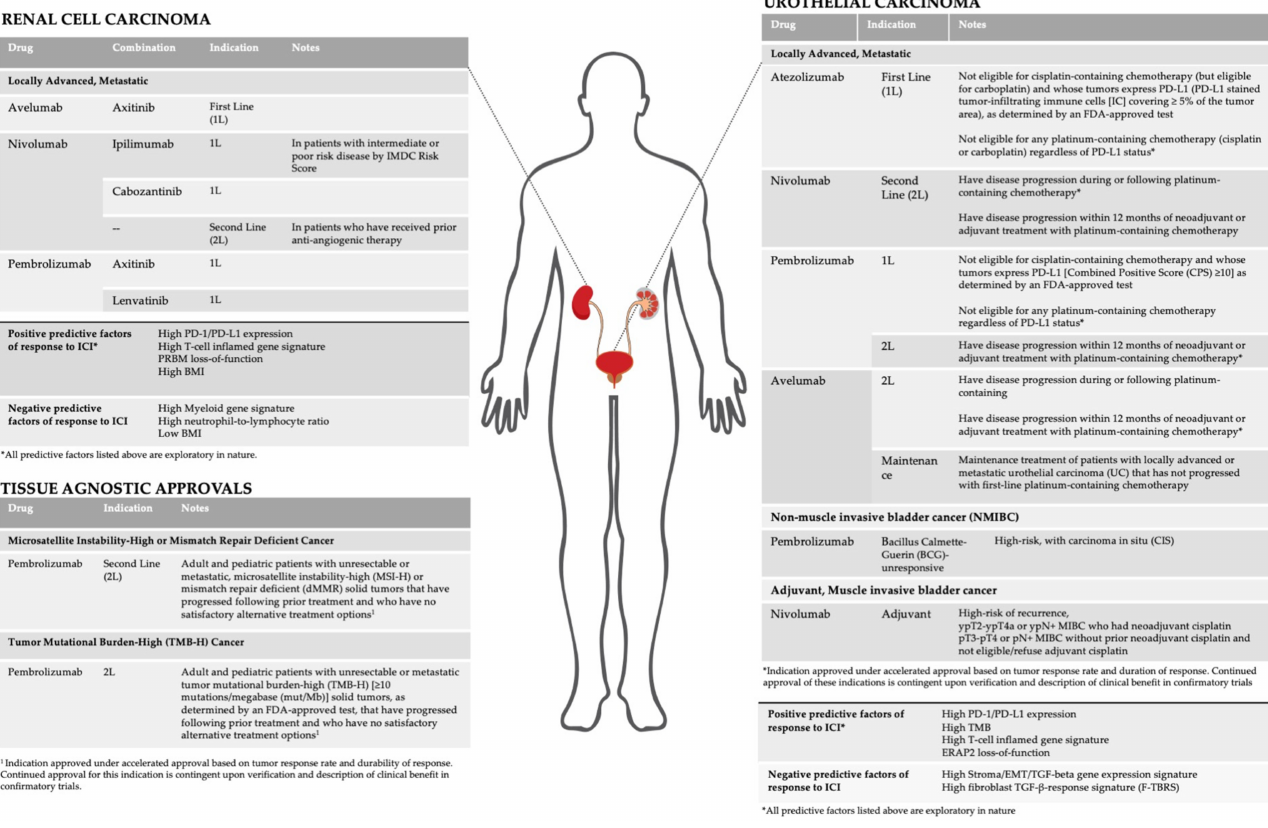
Figure 1. Current indications and biomarkers for immune checkpoint inhibitors in GU